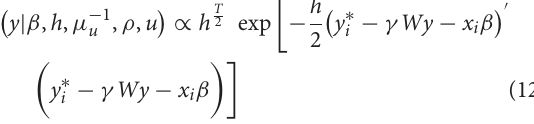
Frontiers in Sustainable Food Systems |